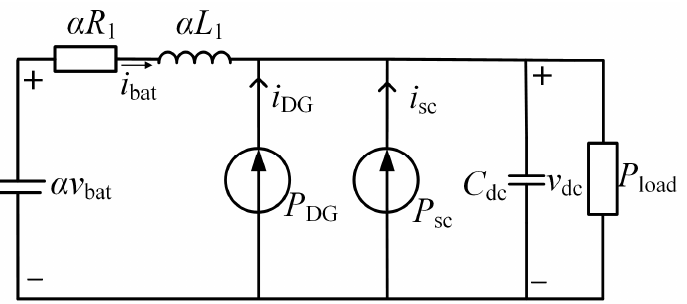
Figure 8. Nonlinear model of a DC microgrid.